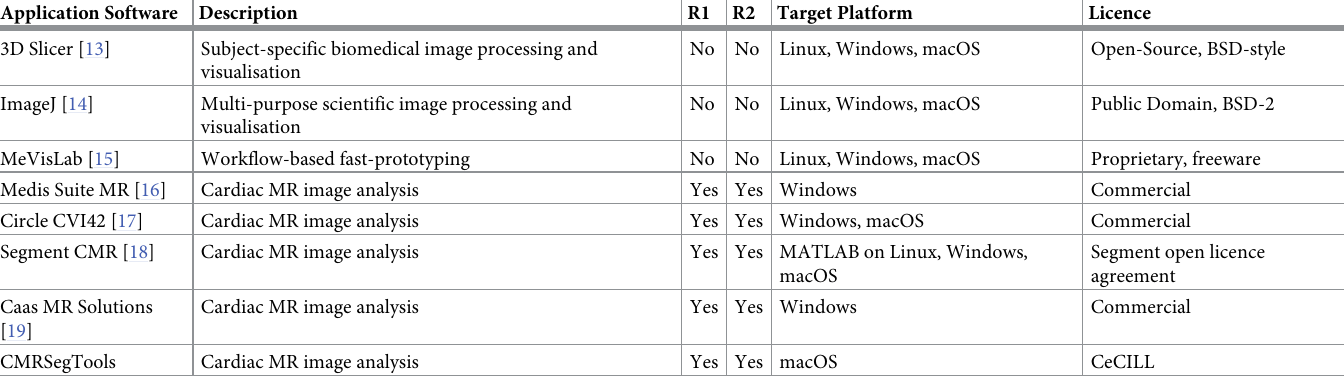
Table 1. Overview of available post-processing tools. Requirement 1 (R1): myocardial segmentation, requirement 2 (R2): statistical analysis and visualisation follow- ing the AHA 17-segment model. Application Software